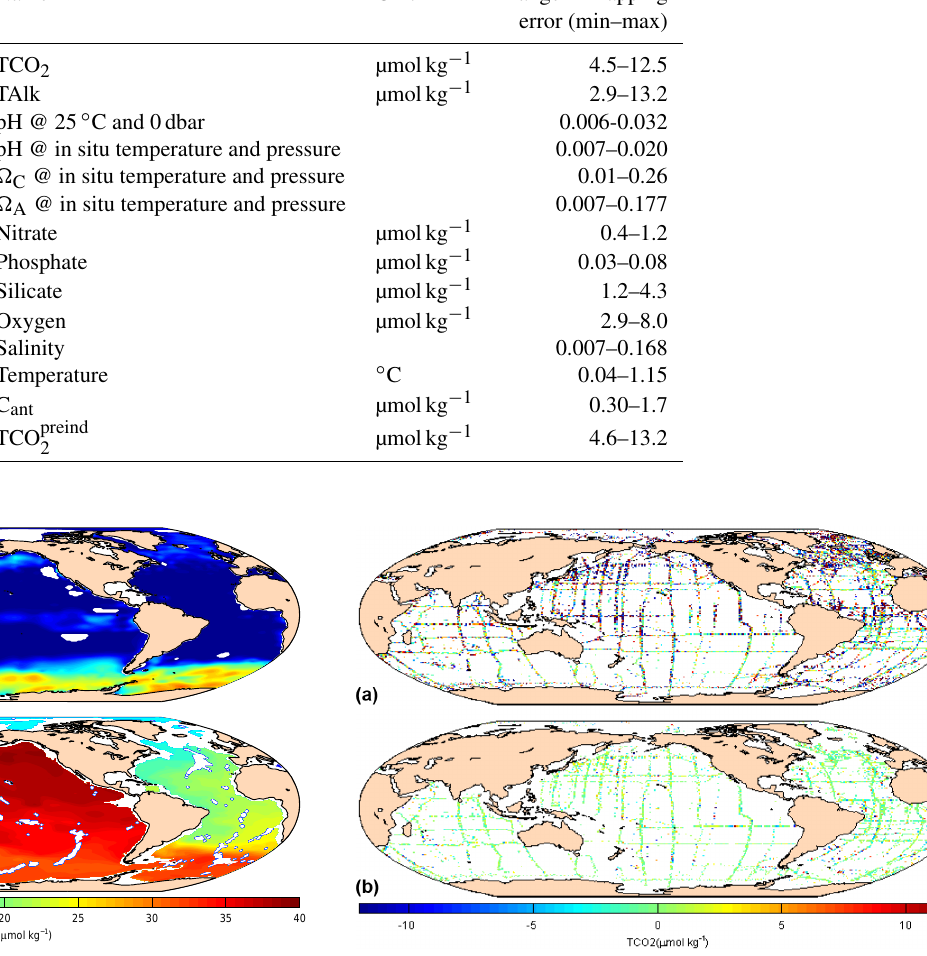
Figure 5. Mapped climatology of nitrate at 10m (a) and 3000m (b) .